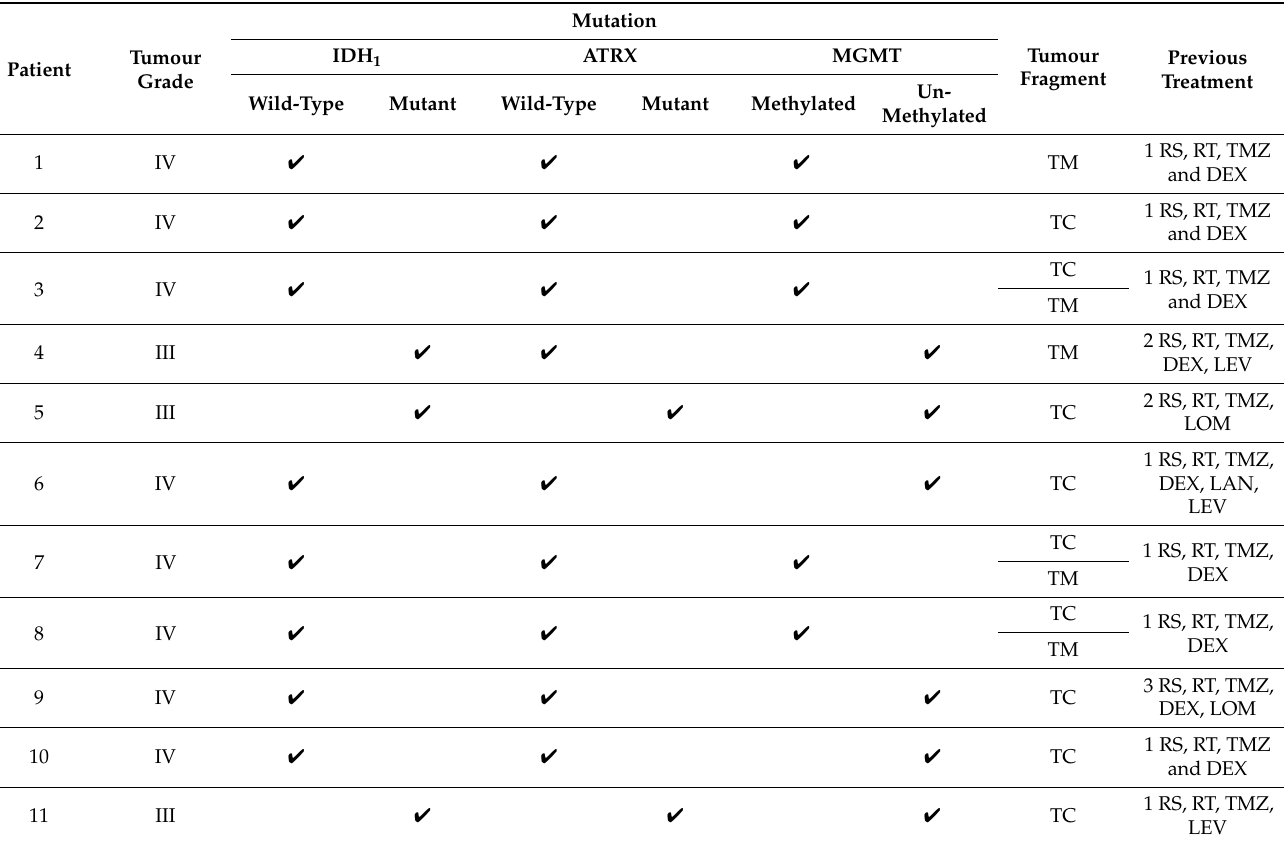
Table 3. Tumour grade, aberrant protein expression and previous treatment for each of the pa- tients’